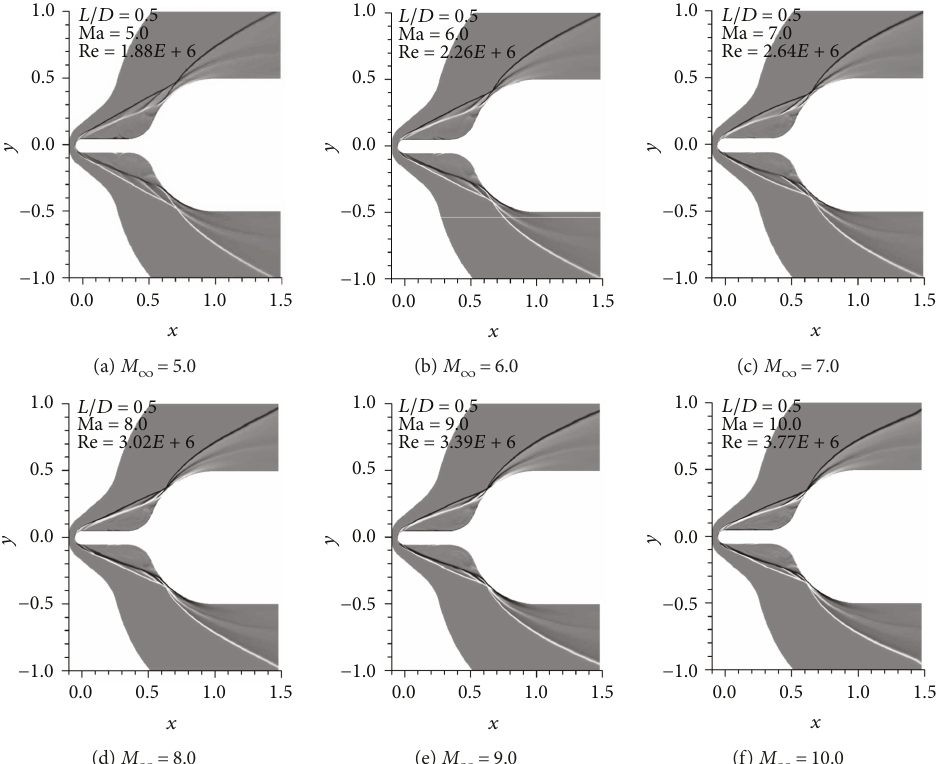
Figure 3: Flow fi eld density gradient in y direction of pure spiked blunt bodies. Spike length L/D = 0.5. L/D = 0.6 Ma = 5.0